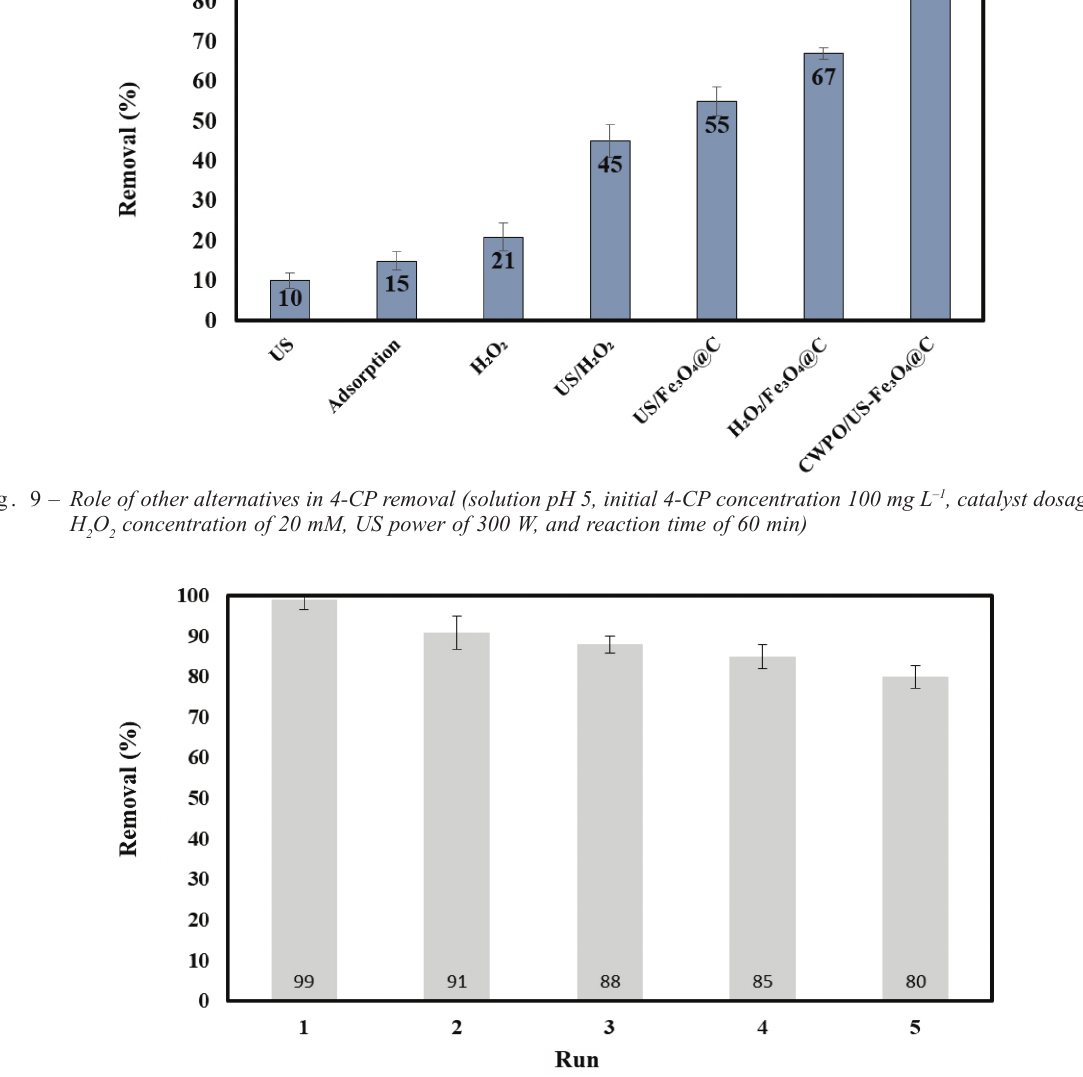
O @C after five consecutive cycles at solution pH 5, initial 4-CP concentration 100 mg L –1 , catalyst Fig. 10 – Reusability of Fe 3 4 dosage 0.8 g L –1 ,